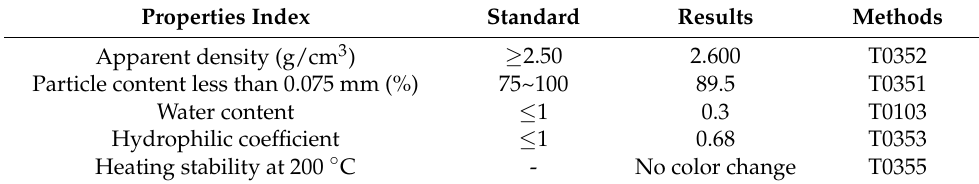
Table 5. Technical indicators of mineral powder.